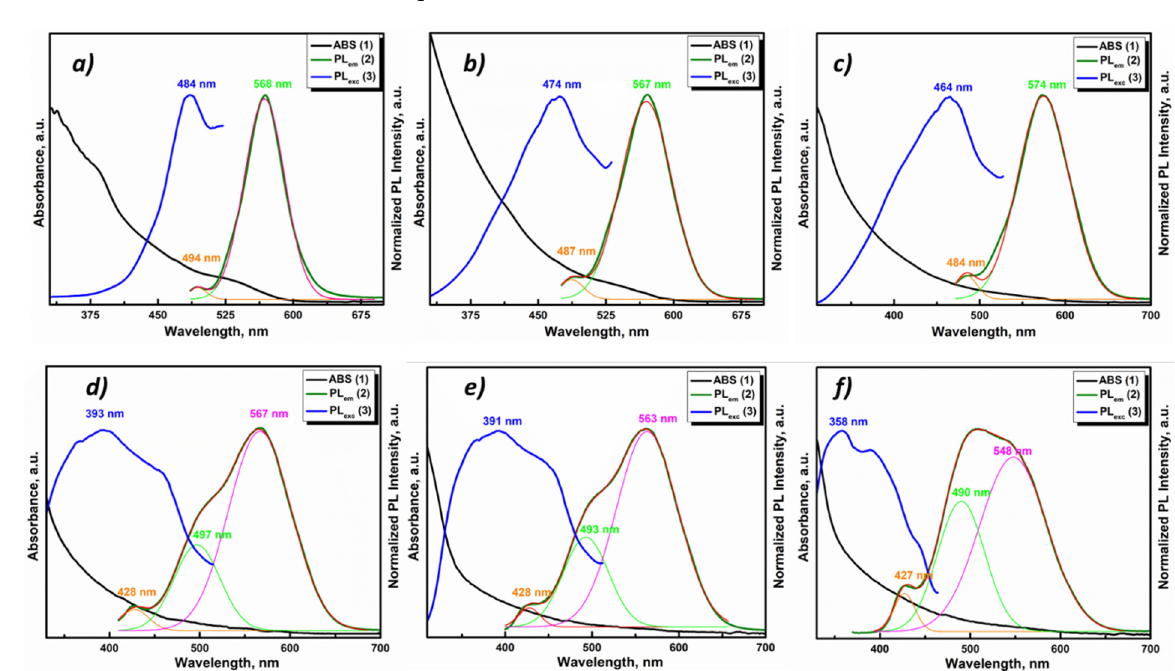
Figure 8. Normalized ABS, PL excitation, and PL emission spectra of core/shell Cd 0.25 Zn 0.75 Se/ZnS QDs with different shell thicknesses: ( a ) Cd 0.25 Zn 0.75 Se core, ( b ) ZnS 1 ML, ( c ) ZnS 2 MLs, ( d ) ZnS 3 MLs, ( e ) ZnS 4 MLs, and ( f ) ZnS 5 MLs.